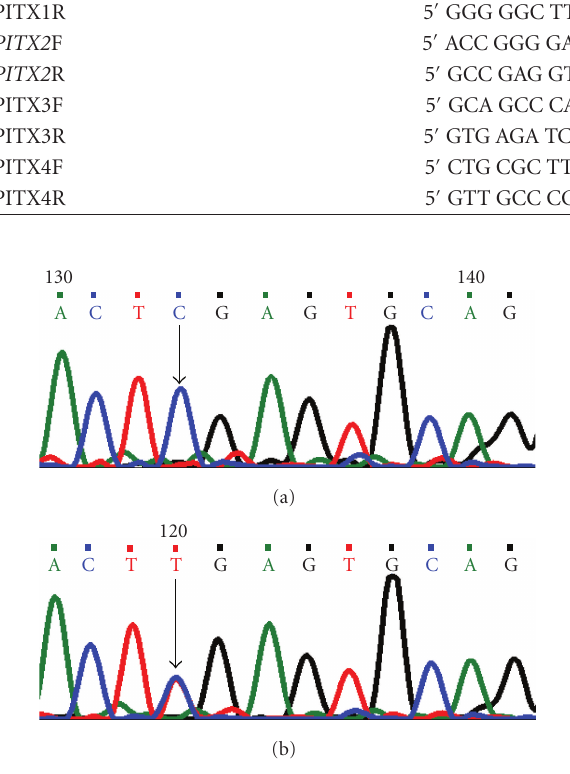
Figure 3: DNA sequence chromatogram of CYP1B1 exon 3 equivalent to codon 354–357. (a) The reference sequence derived from control is shown. (b) Sequence derived from ARS patient shows heterozygous c.1063C > T, which predicts a codon change CGA > TGA and heterozygous p.R355X, a non-sense